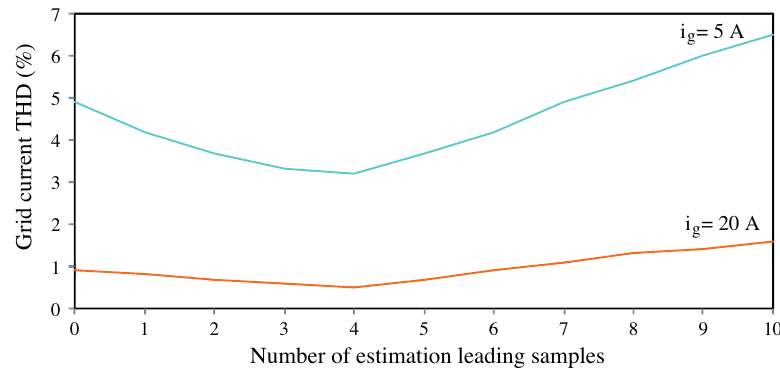
Figure 10. Line current THD as a function of the number of leading samples n f using the CE method with IPCC.